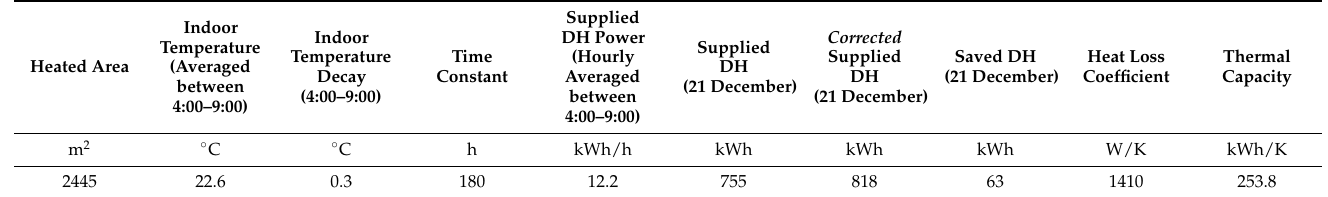
Table 1. Summary of the results, including indoor temperature and its decay, delivered power, calculated building time constant, and thermal